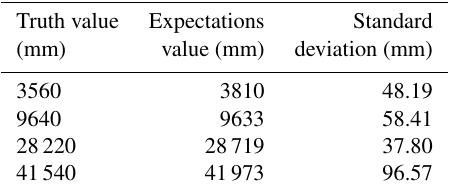
Table 1. Expectation and standard deviation of distance measure-